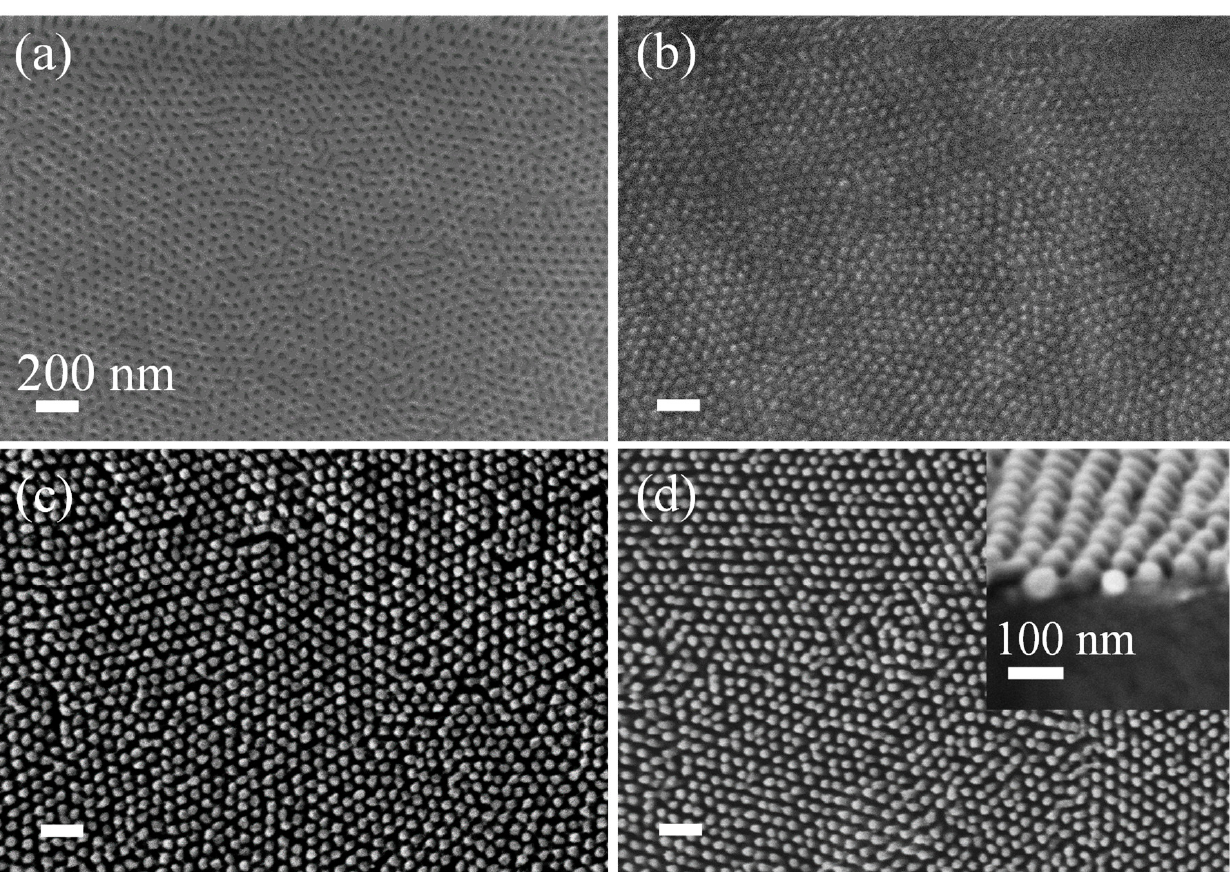
Figure 5. SEM images of ( a ) PS- b -PMMA BCP layer assembled over passivated SiO 2 / MR-8 substrate, ( b ) BCP layer after eight cycles of AlO x SIS, ( c ) AlO x nanocylinders after O 2 plasma, and ( d ) AlO x /ZnO composite cylinders, templated by the layer at ( a ) using two cycles of AlO x SIS and six cycles of ZnO SIS, followed by O 2 plasma. The inset shows a cross-sectional view of the AlO x /ZnO cylinders.